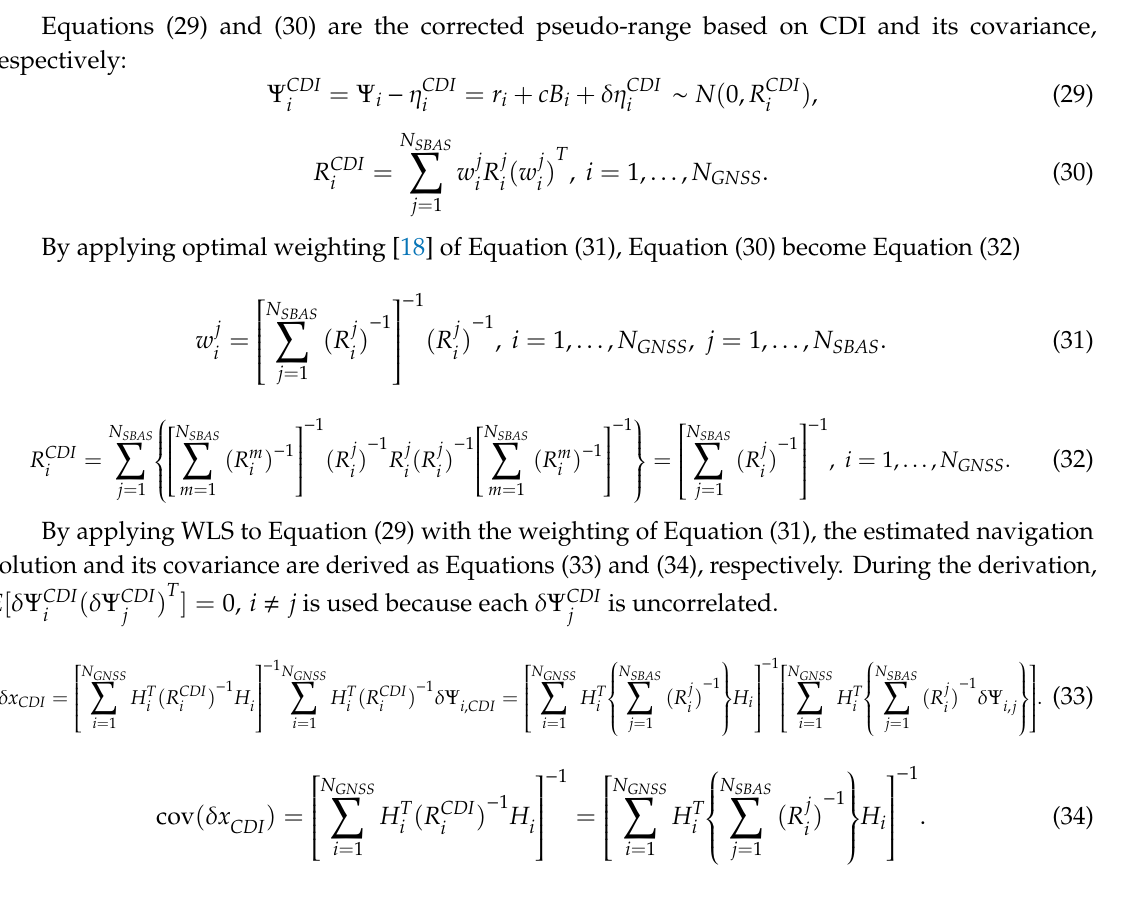
Figure 5. CDI for multi-GNSS augmented with multi-SBAS.